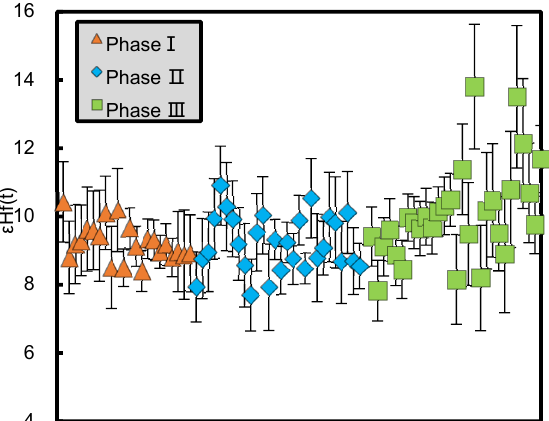
Figure 6. Variations of ε Hf (t) values in zircons of different phases. Phase I, II and III had similar ε Hf (t) values. Error bars are 1 σ .